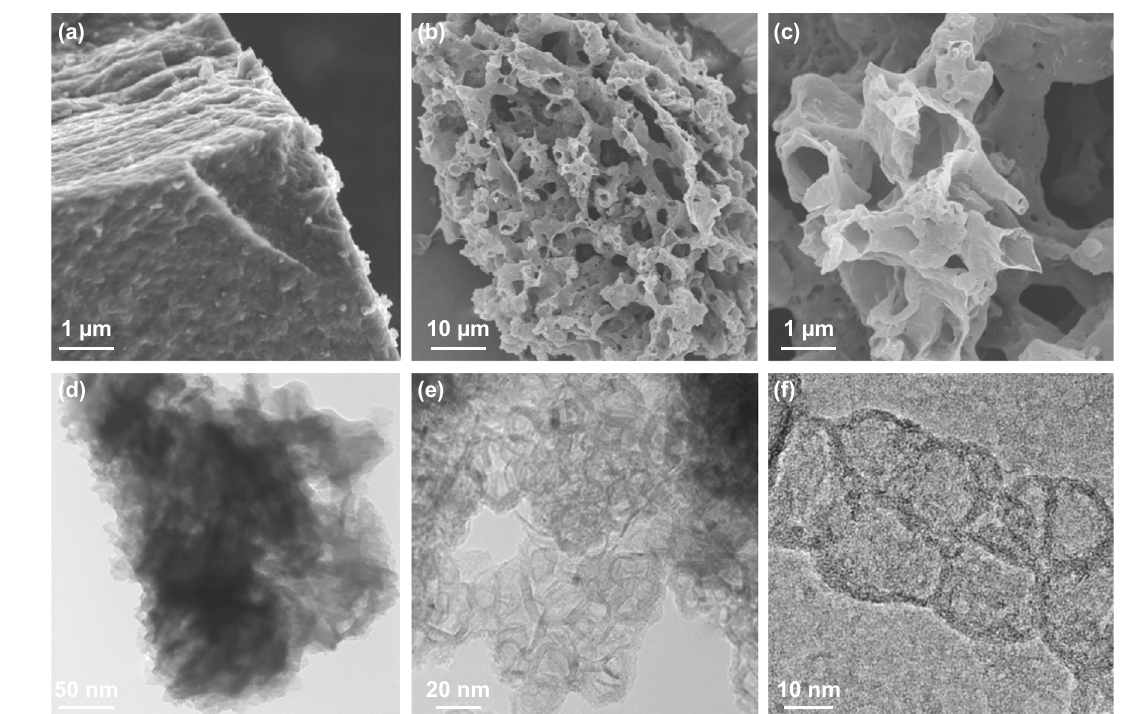
Fig. 1 SEM images of a pure PVP-derived carbon and b , c 3DCFs. TEM images of d pure PVP-derived carbon and e 3DCFs. f High-resolution TEM image of 3DCFs consisting of continuous nanocages (10–20 nm) with ultrathin walls (ca. 2